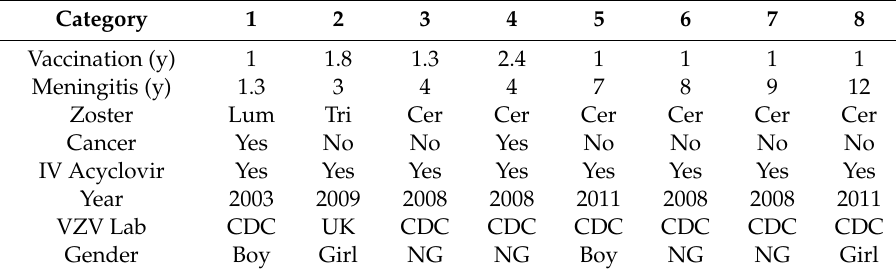
Table 1. Vaccine virus meningitis in once-immunized children.